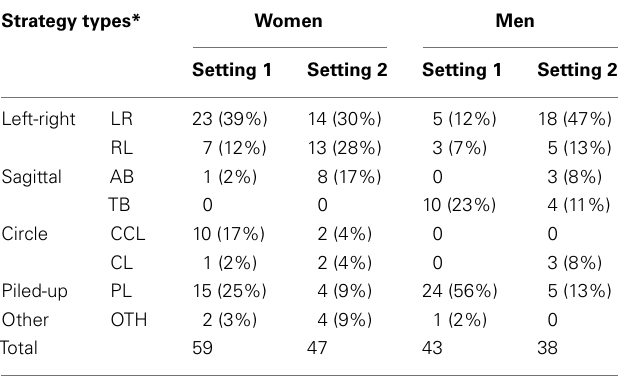
Table 5 | Results of the card arranging time